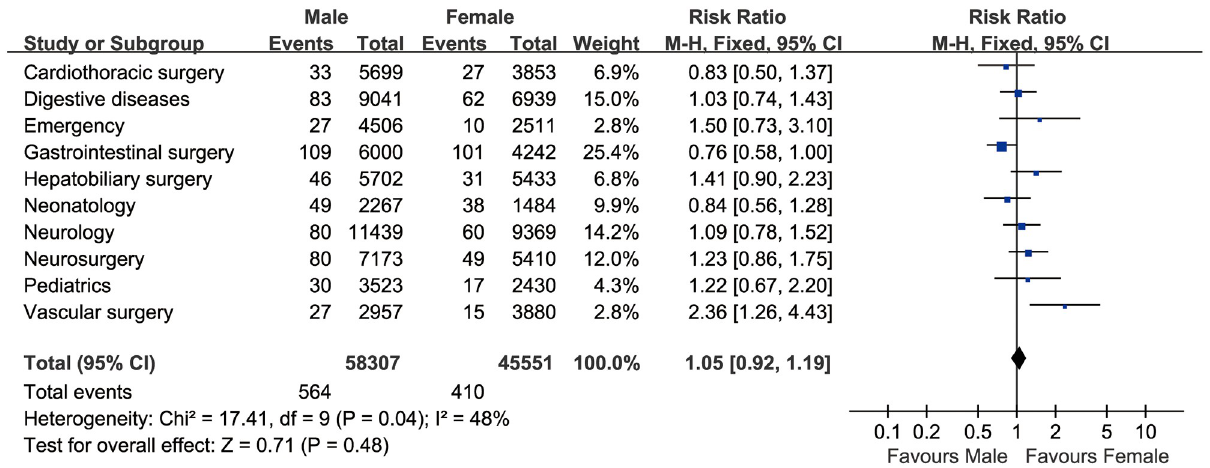
Fig 2. The pooled OR based on the top ten high lipemia incidence departments (n = 103,857).